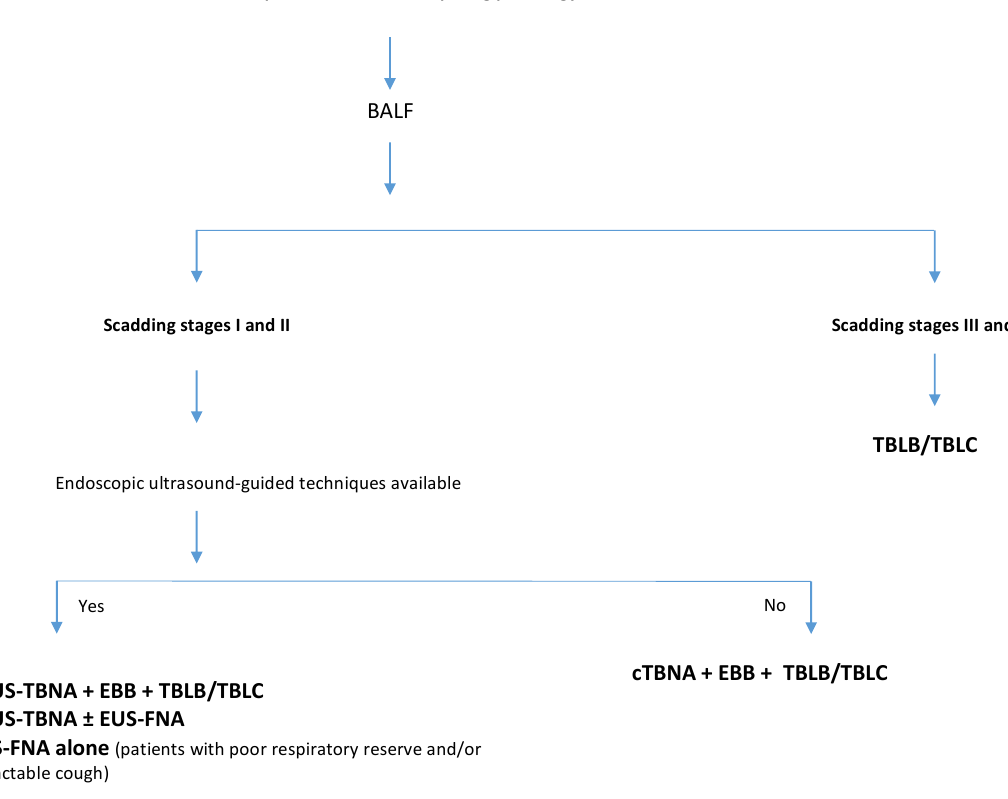
Figure 2. Proposed diagnostic flowchart for bronchoscopic diagnosis of sarcoidosis. BALF: broncolaveolar lavage fluid; EBUS-TBNA: endobronchial ultrasound-guided transbronchial